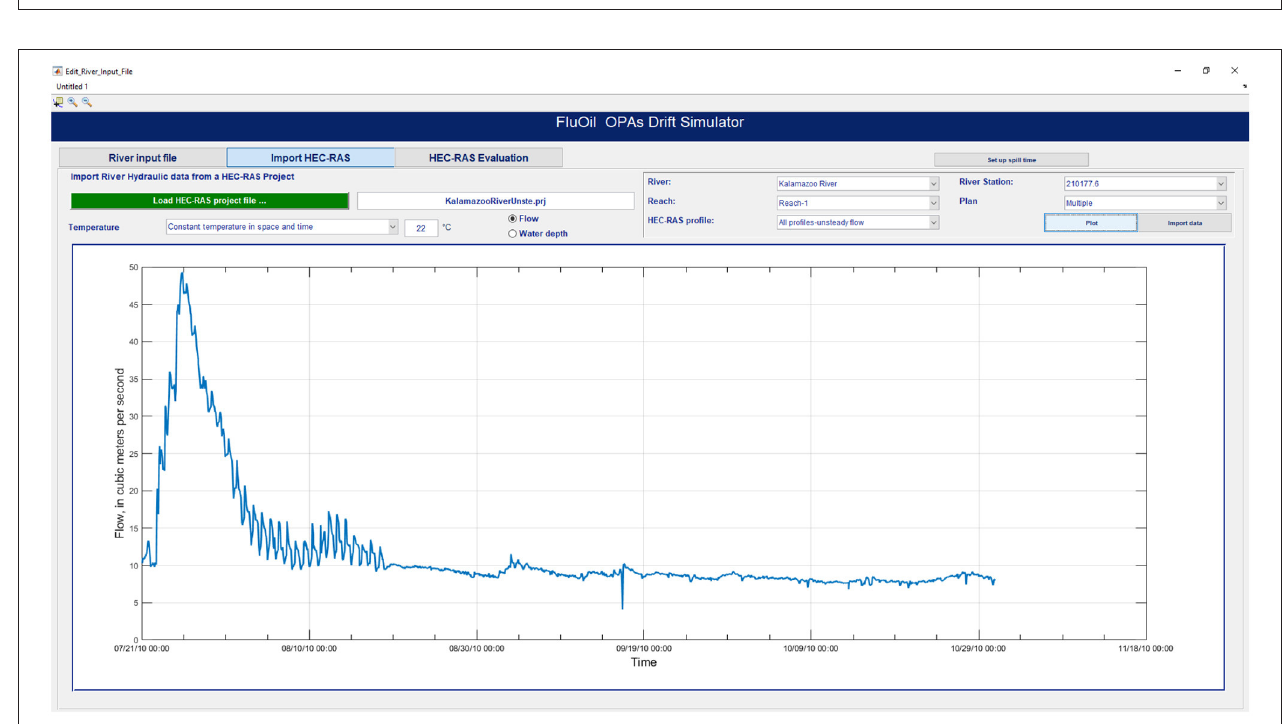
FIGURE 2 | Example of the FluOil graphical user interface (GUI).